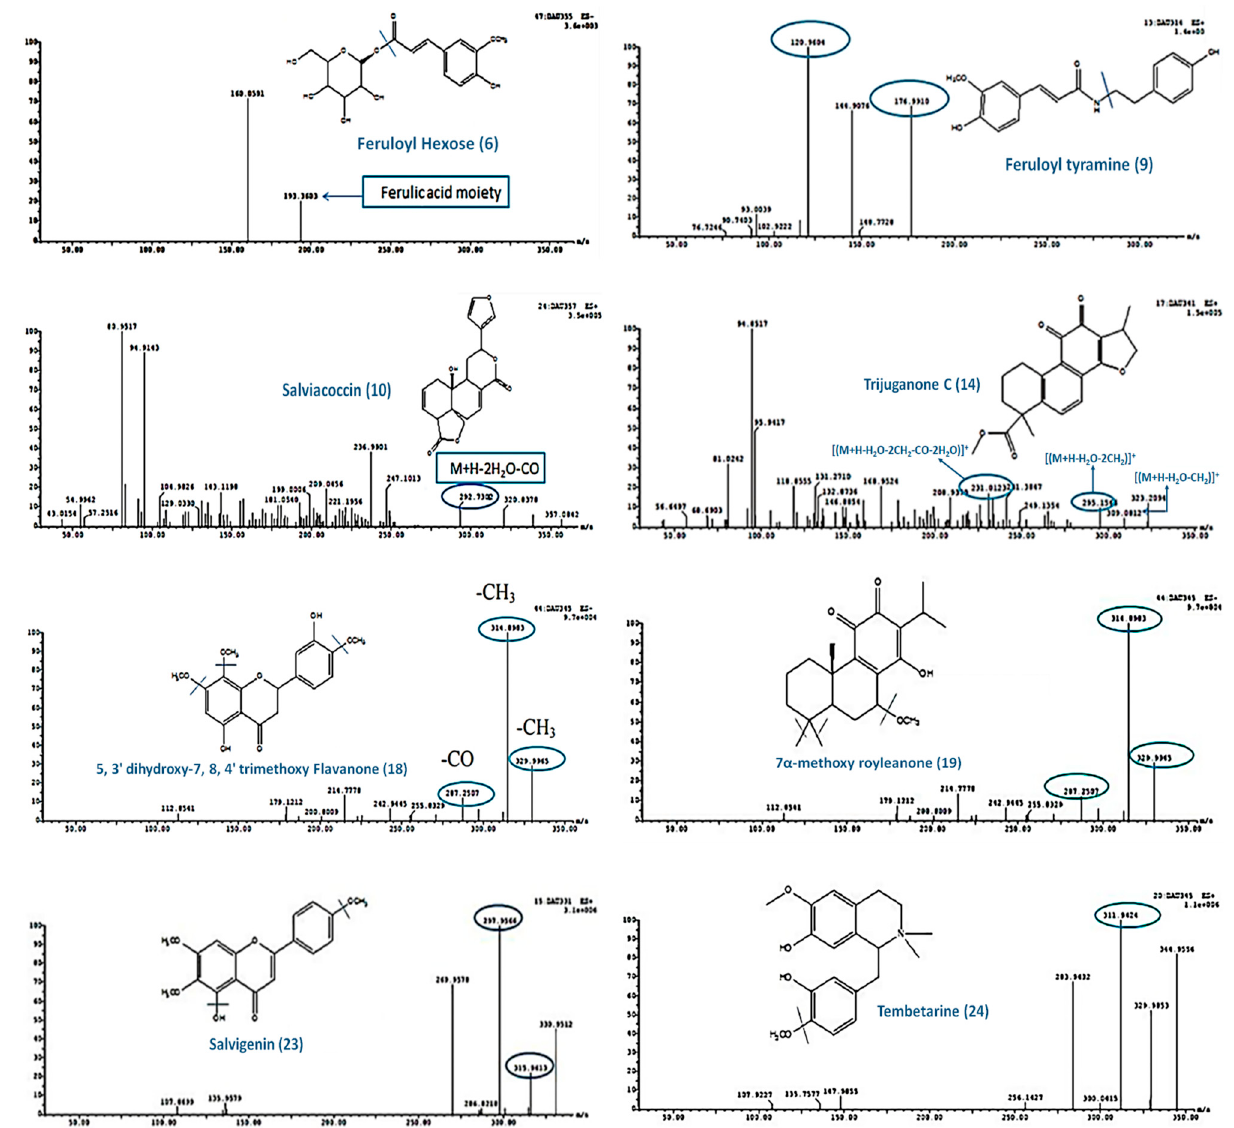
Figure 4. ESI-MS/MS spectrum of some compounds from the dichloromethane fraction of S. hispanica L. aerial parts.